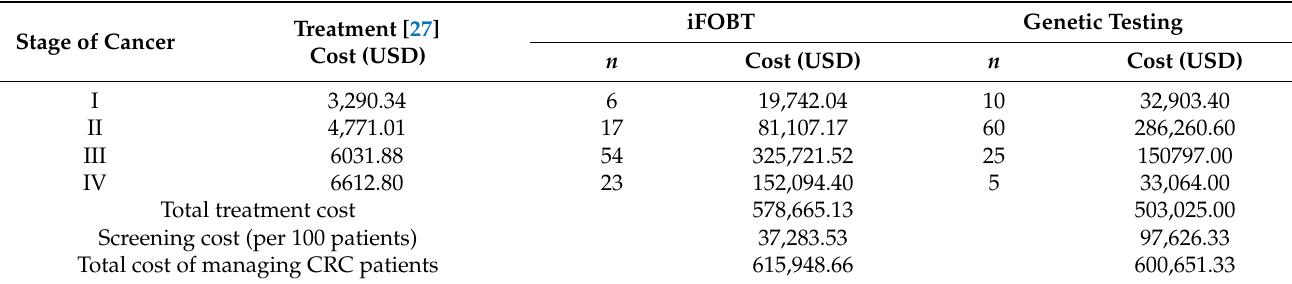
Table 7. Cost of managing colorectal cancer patients.